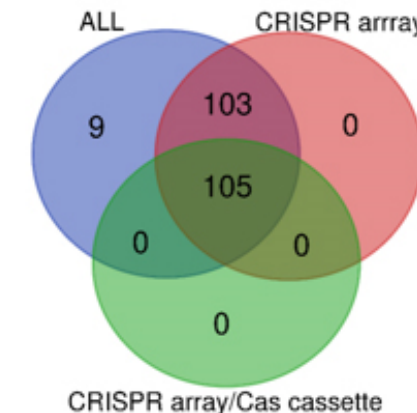
Figure 1. Venn diagrams of CRISPR/Cas element distribution for CriePir P. aeruginosa isolates se- quenced by us ( left ) and reference isolates available from Pseudomonas genome DB ( right ).